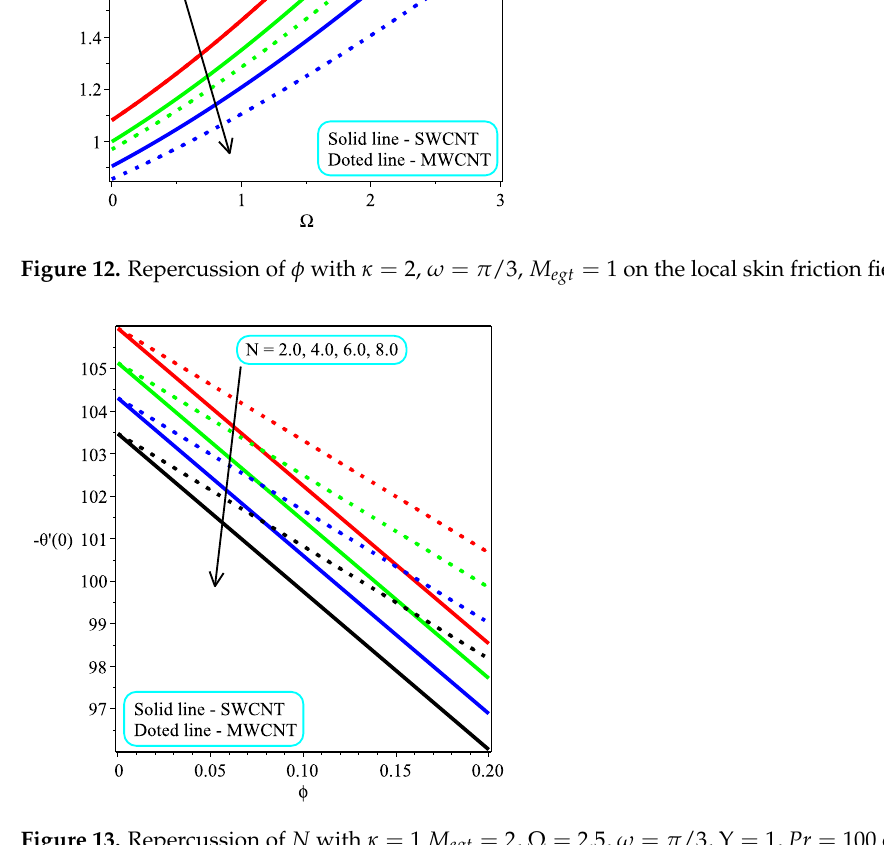
Figure 13. Repercussion of N with κ = 1 M egt = 2, Ω = 2.5, ω = π /3, Υ = 1, Pr = 100 on − θ (cid:48) ( 0 ) .